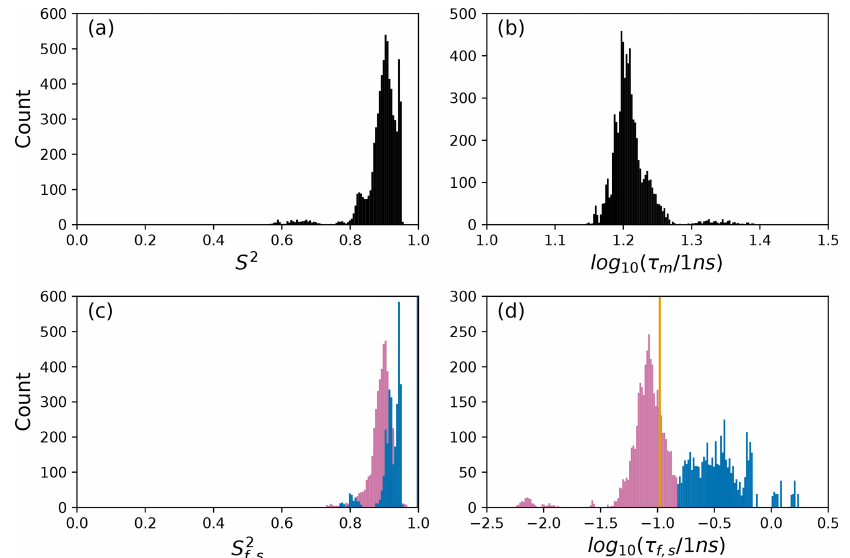
or τ f (reddish-purple) f = 1 is observed f